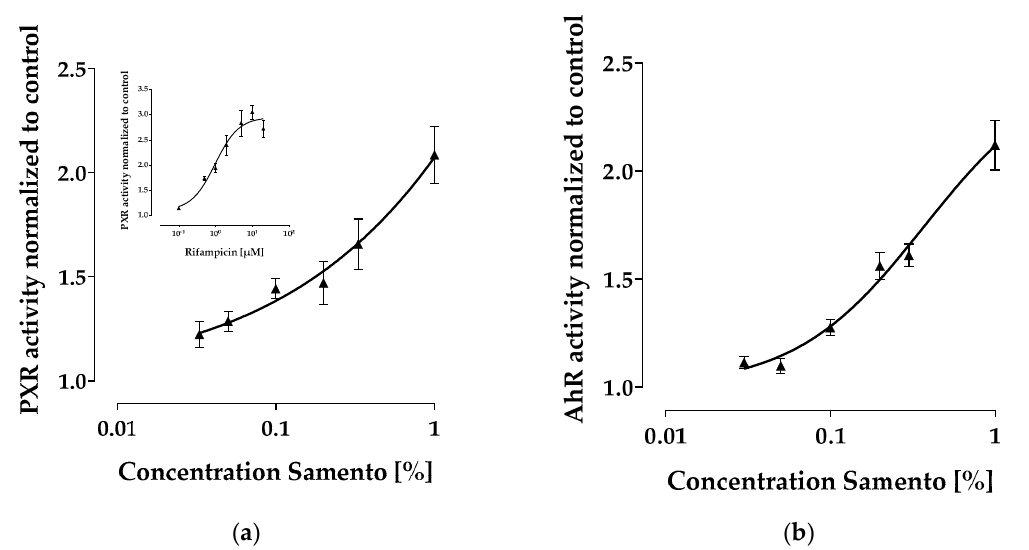
Figure 4. Results of the reporter gene assays. Each curve depicts the results of three experiments with each concentration tested in triplicate. ( a ) Concentration-dependent effect of Samento and the positive control rifampicin (insert) on pregnane x receptor (PXR) activity. ( b ) Concentration-dependent effect of Samento and the positive control omeprazole (insert) on aryl hydrocarbon receptor (AhR) activity.